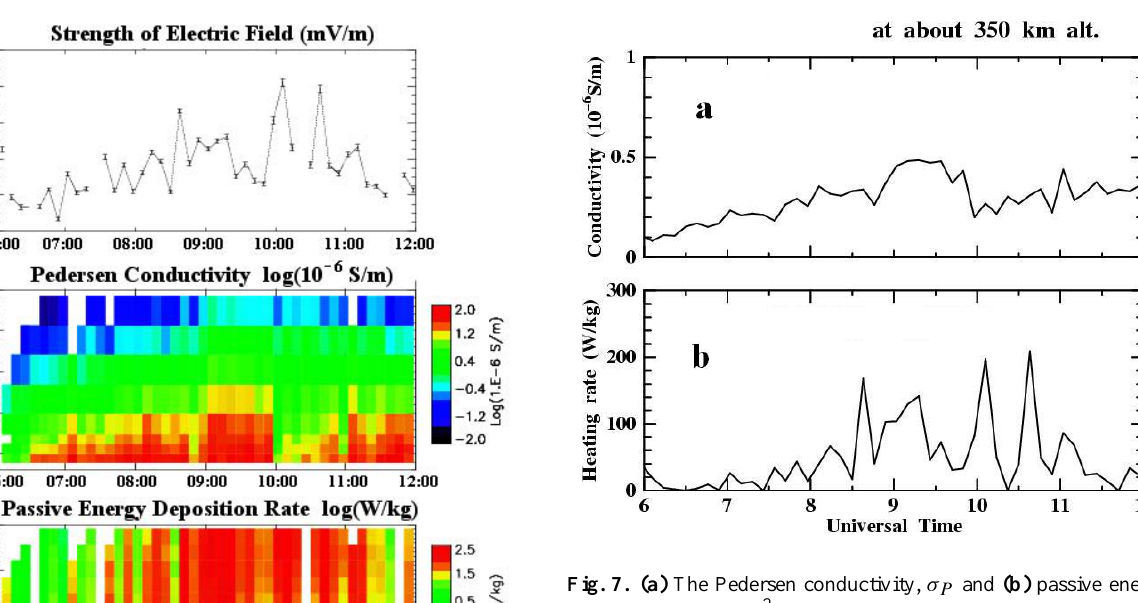
Fig. 7. (a) The Pedersen conductivity, σ P and (b) passive energy deposition rate, σ P E 2 / ρ , at about 350km altitude obtained from the ESR observations during 06:00–12:00 UT. These are the same as those shown in Fig. 6 except for line plots at a specific